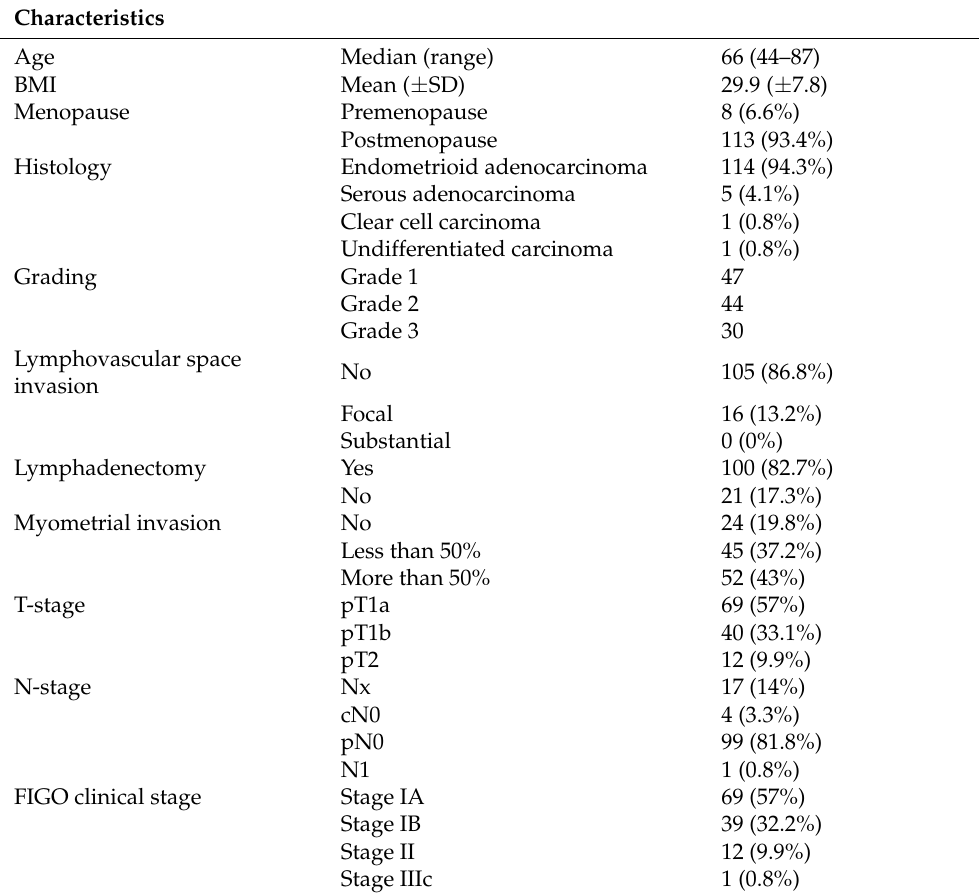
Table 1. Patients and disease